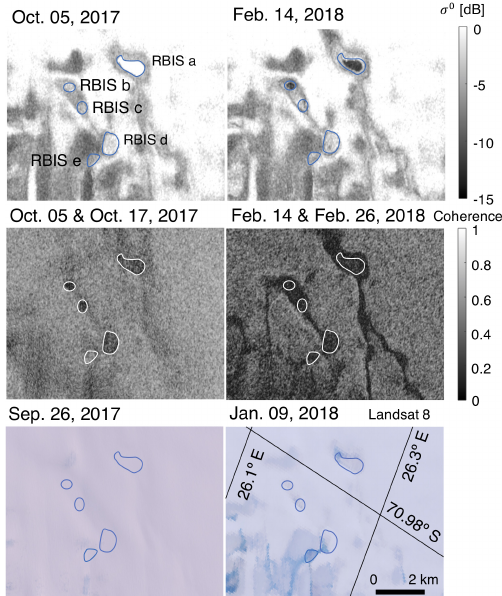
Figure 8. Coherence and σ 0 in the RBIS region before (left panels) and during (right panels) the surface melt in the vicinity of RBIS a in the panels R1 of Fig. 1. These lakes are hereafter referred to as RBIS a to e. Two near-contemporaneous Landsat true colour images are also shown (bottom panels). The Landsat images are acquired from Google Earth Engine (Gorelick et al.,